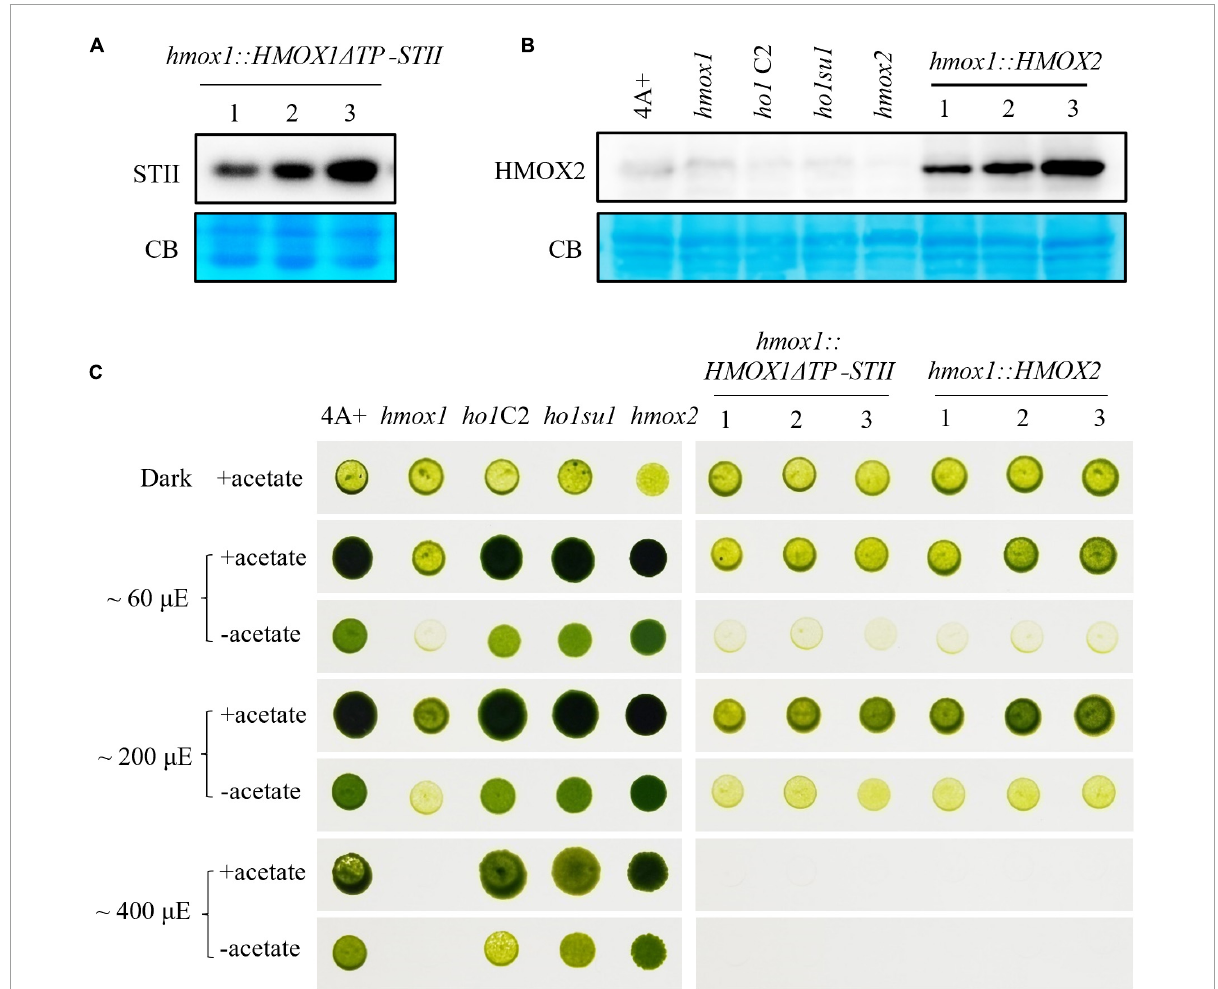
FIGURE5 Characterization of hmox1 expressing either HMOX2 or truncated HMOX1. (A) Immunoblotting analysis of hmox1 expressing HMOX1 (cid:49) TP-STII. An anti-STII tag antibody was used. (B) Immunoblotting analysis of different strains expressing the HMOX2 protein. Equal amounts of protein extracted from 4A+, hmox1 , ho1C2 ( hmox1 cDNA complemented line), ho1su1 , hmox2, and hmox1::HMOX2 (HMOX2 overexpression lines in hmox1 ) were analyzed using immunoblotting. Anti-HMOX2 antibodies were used. (C) Growth of 4A+, hmox1 , ho1C2 , ho1su1 , hmox2 , hmox1::HMOX1 (cid:49) TP-STII, and hmox1::HMOX2 . The strains were grown on TAP (with acetate) or TP (without acetate) media at different fluence rates of